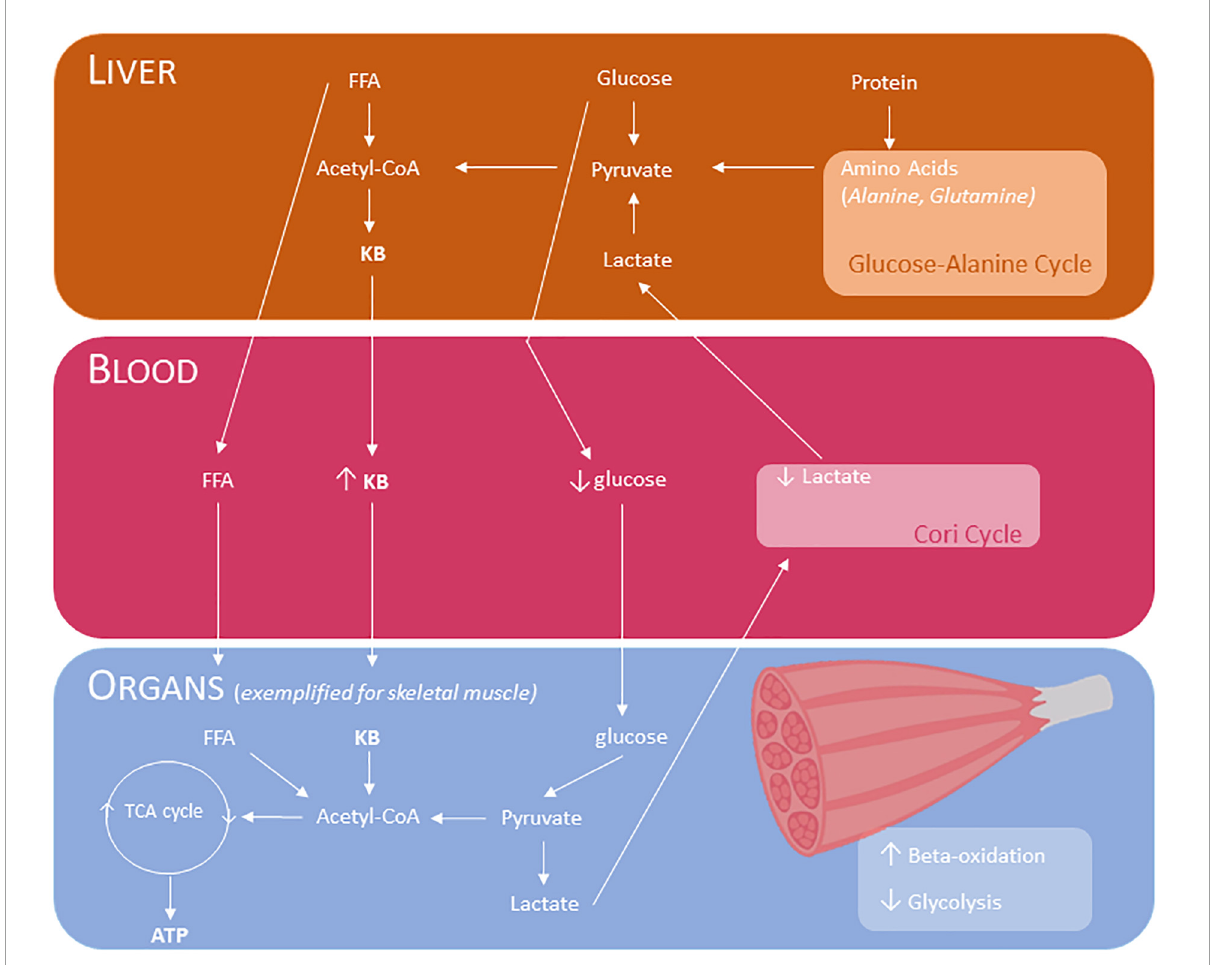
FIGURE1 Effects of ketogenic diet and ketone body supplementation and downstream metabolism, exemplified for skeletal muscle. The liver produces ketone bodies during fasting, starvation, in carbohydrate restriction, or prolonged intense exercise. These ketone bodies can be used for input in the TCA cycle in various tissues, including the muscle to generate ATP. The Cori cycle, also known as lactic acid cycle, is the pathway in which lactate is transported to the liver and converted into glucose. Glucose-alanine cycle is the pathway in which alanine is transported to the liver and converted into glucose. KB, ketone bodies (acetoacetic acid/acetoacetate, acetone and beta-hydroxybutyric acid); TG, triglycerides; FFA, free fatty acids; Acetyl CoA, Acetyl coenzyme A; TCA, tricarboxylic acid; ATP, Adenosine